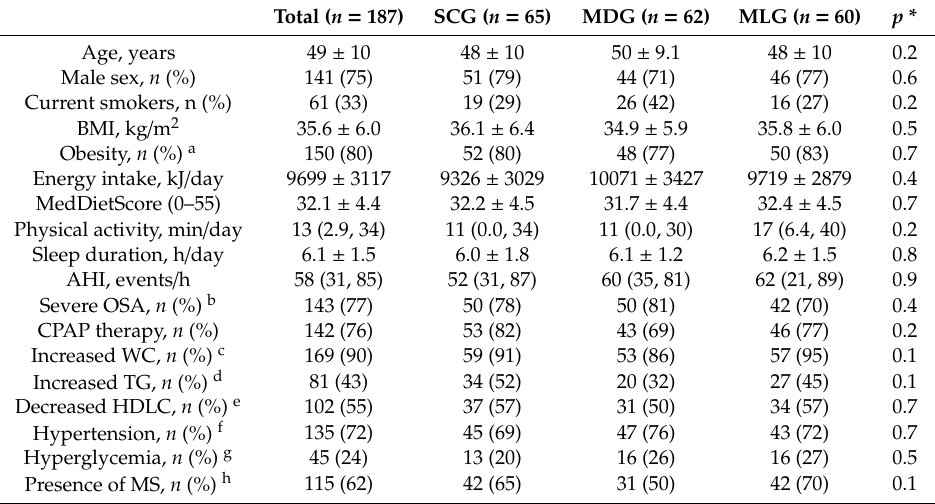
Table 1. Baseline characteristics of the total randomized sample and the three study